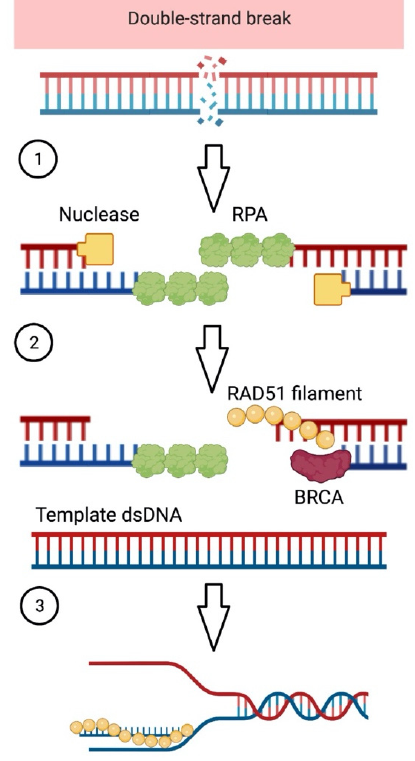
Figure 1. Breaks in double-stranded DNA (dsDNA) can be repaired through the homologous recombination repair (HRR) pathway. ( 1 ) The processing of double-stranded DNA (dsDNA) close to the broken ends by nuclease enzymes, which generates single-stranded DNA (ssDNA) overhangs, is the initial step. Replication protein A coats and protects the overhangs (RPA). ( 2 ) BRCA2 catalyzes the substitution of RPA with the RAD51 protein, resulting in the formation of a RAD51–ssDNA filament. ( 3 ) The filament invades a second DNA molecule with a matched sequence, which serves as a repair template. Created with BioRender.com. Table 1. Most representative genes involved in the homologous recombination repair pathway